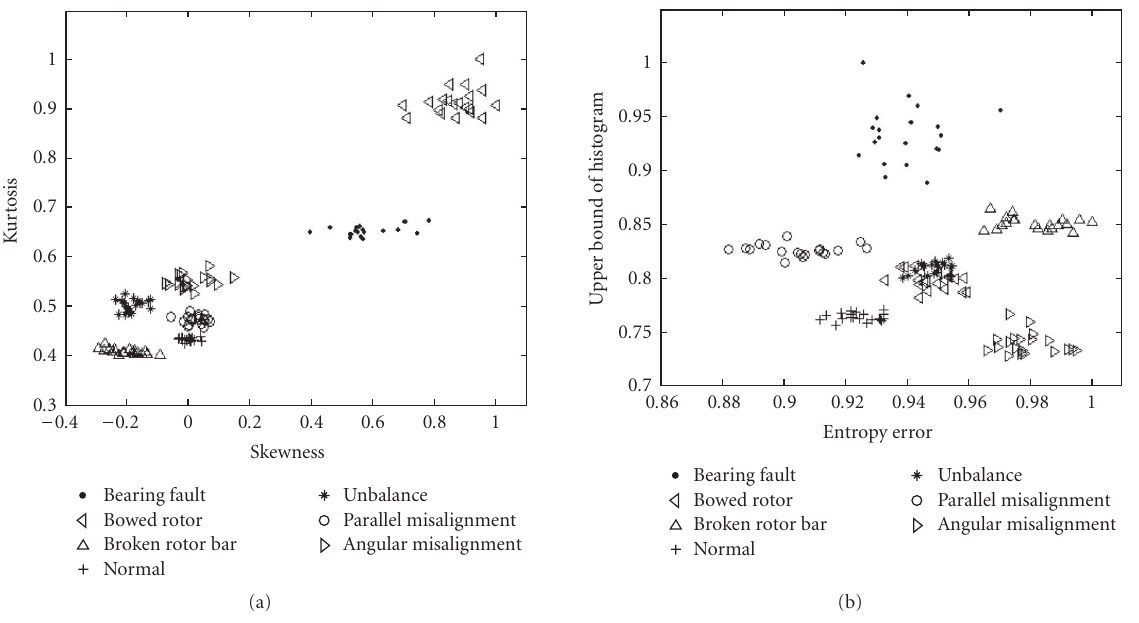
Figure 9: Typical feature parameters after feature extraction. (a) Kurtosis and skewness, (b) upper bound of histogram and entropy error.